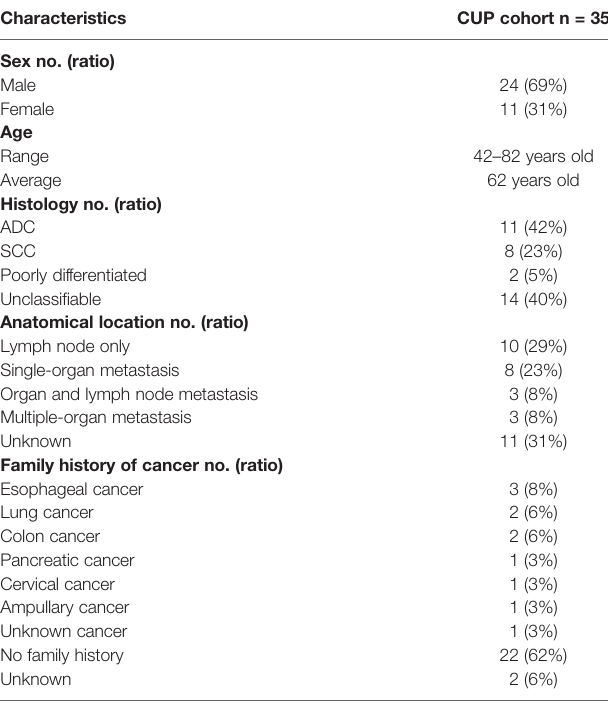
TABLE 1 | Clinical information of CUP patients.